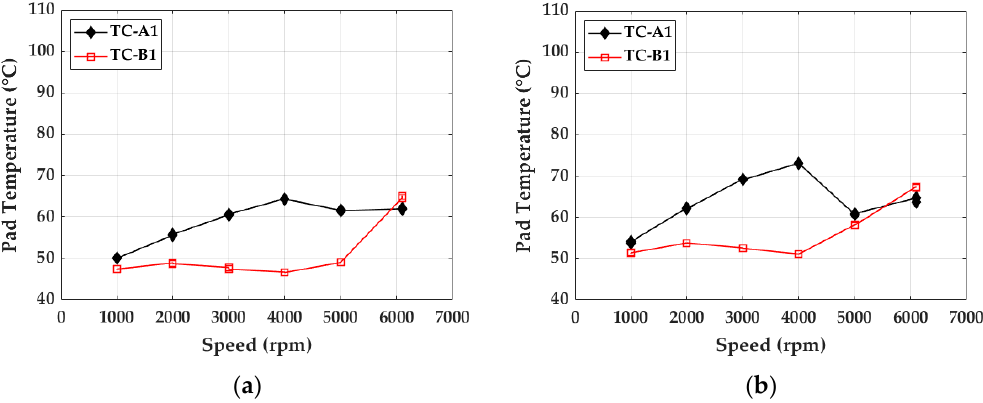
Figure 19. Flooded Rocker Pivot bearing pad temperatures @ 25% of pad arc: ( a ) 1.3 MPa, ( b ) 2.1 MPa.